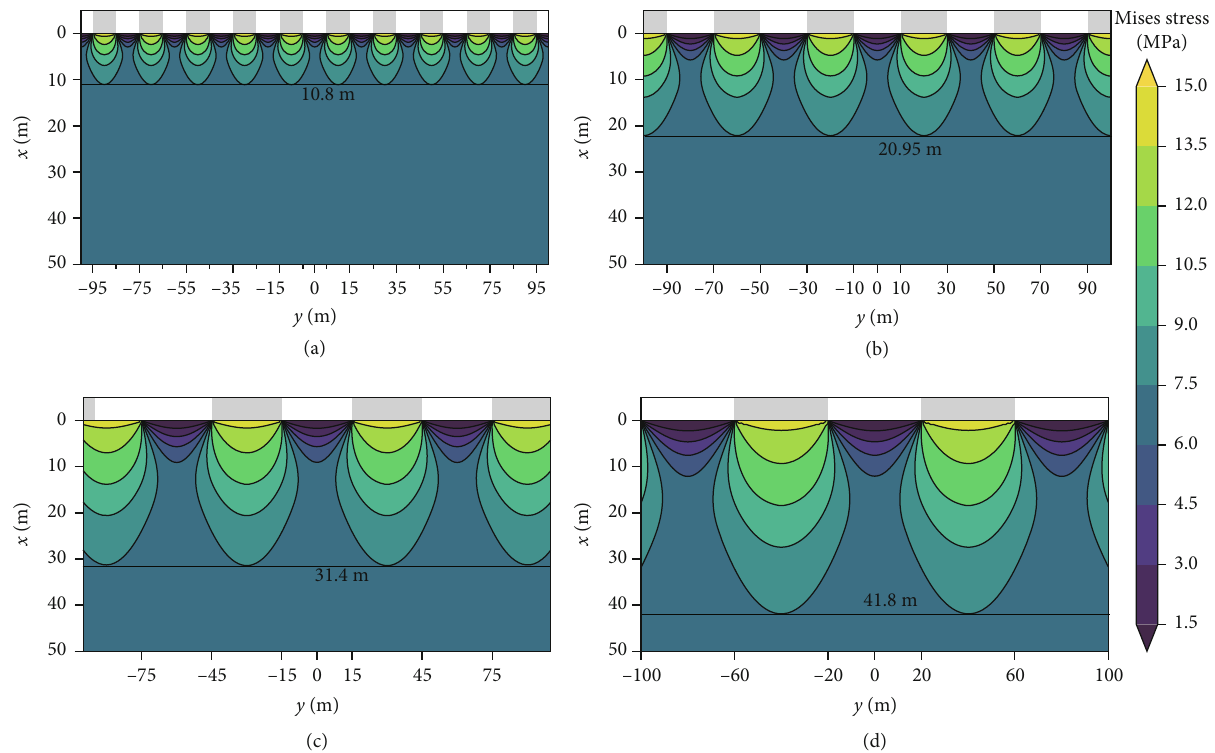
Figure 9: Cloud maps of von Mises stress distributions when the width of the excavated coal pillar is (a) 10 m, (b) 20 m, (c) 30 m, and (d) 40